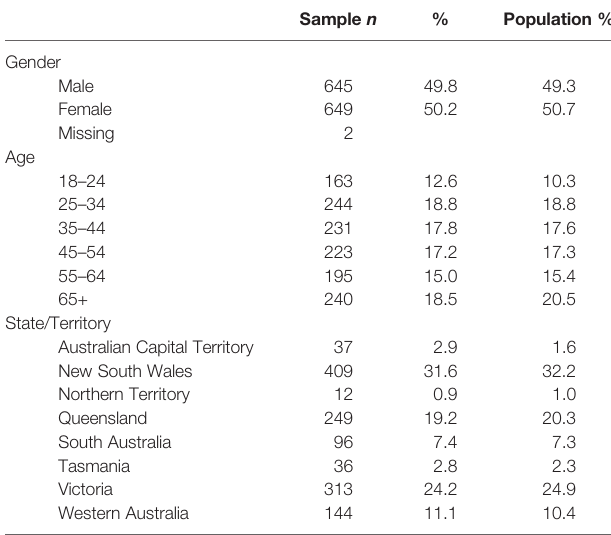
TABLE 1 | Sample demographics and comparison with population data from the 2016 Australian Census